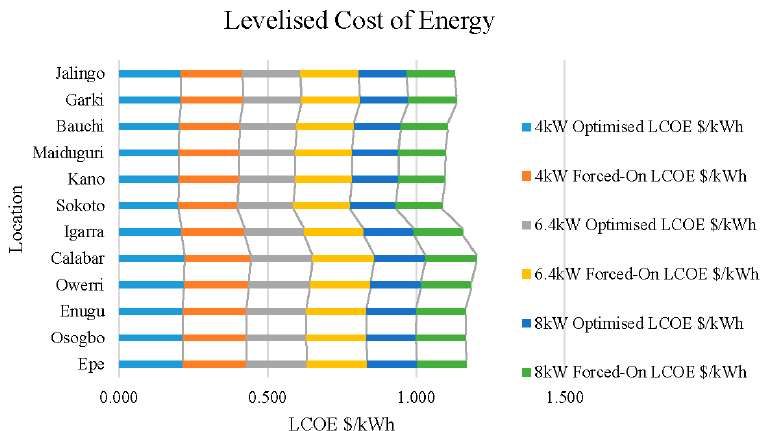
Figure 5. Levelised cost of energy ($/kWh).